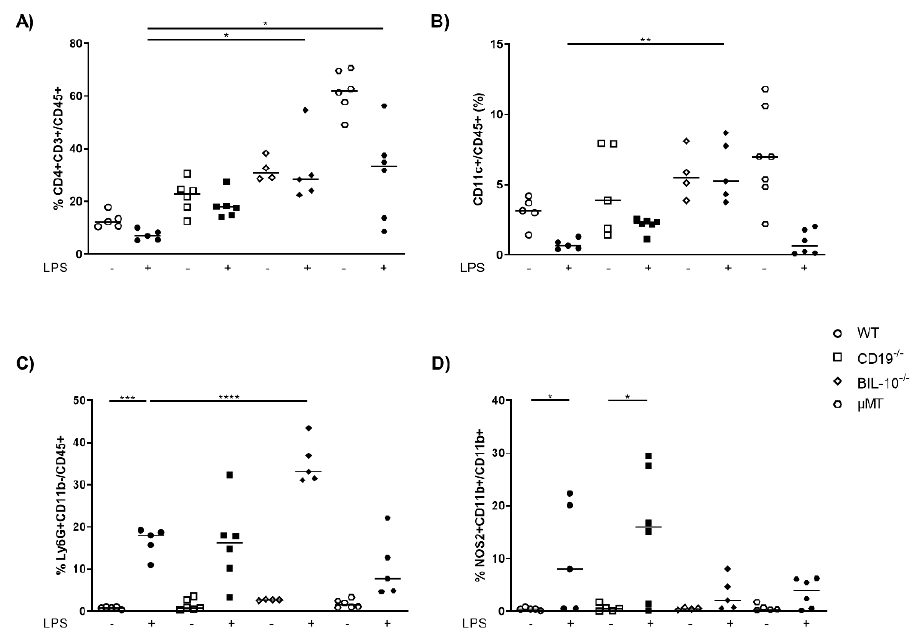
Figure 2. Loss of B cell-specific IL-10 influences the cellular composition in peritoneal cavity after LPS challenge at gd16. 24 h after PBS or LPS injection in WT, CD19 − / − , BIL-10 − / − and µ MT mice, percentages of CD4+ T cells ( A ), CD11c+ DC ( B ) and Ly6G+CD11b- granulocytes ( C ), analyzed